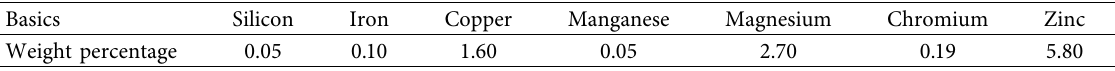
Table 1: Chemical composition of AA7075.